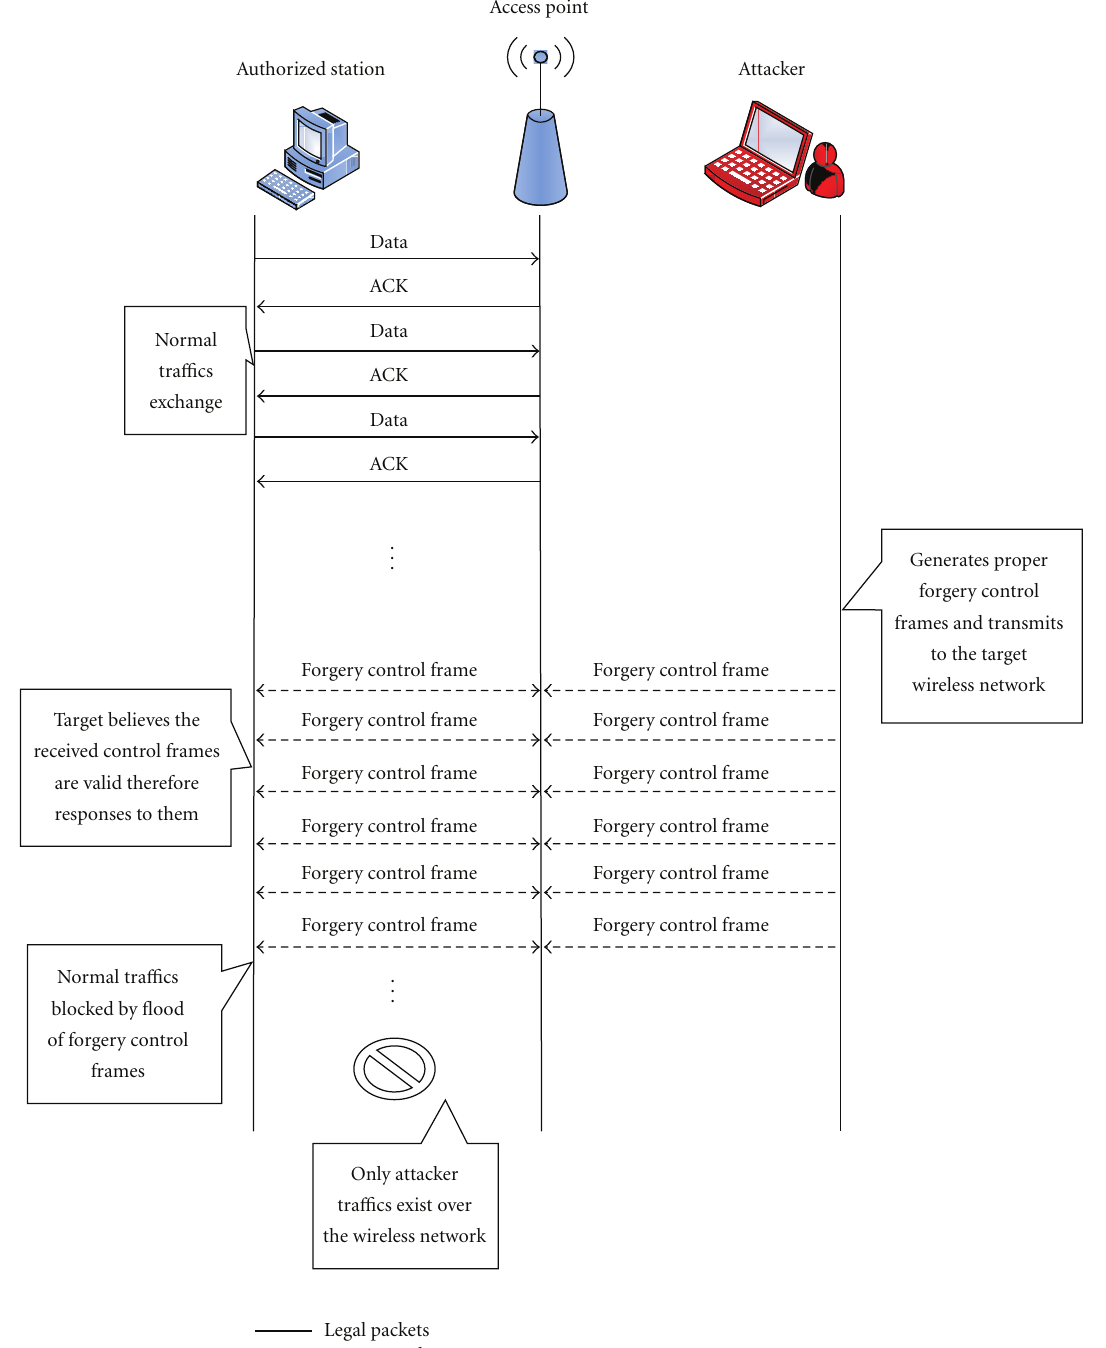
Figure 16: Attack model to conduct wireless DoS